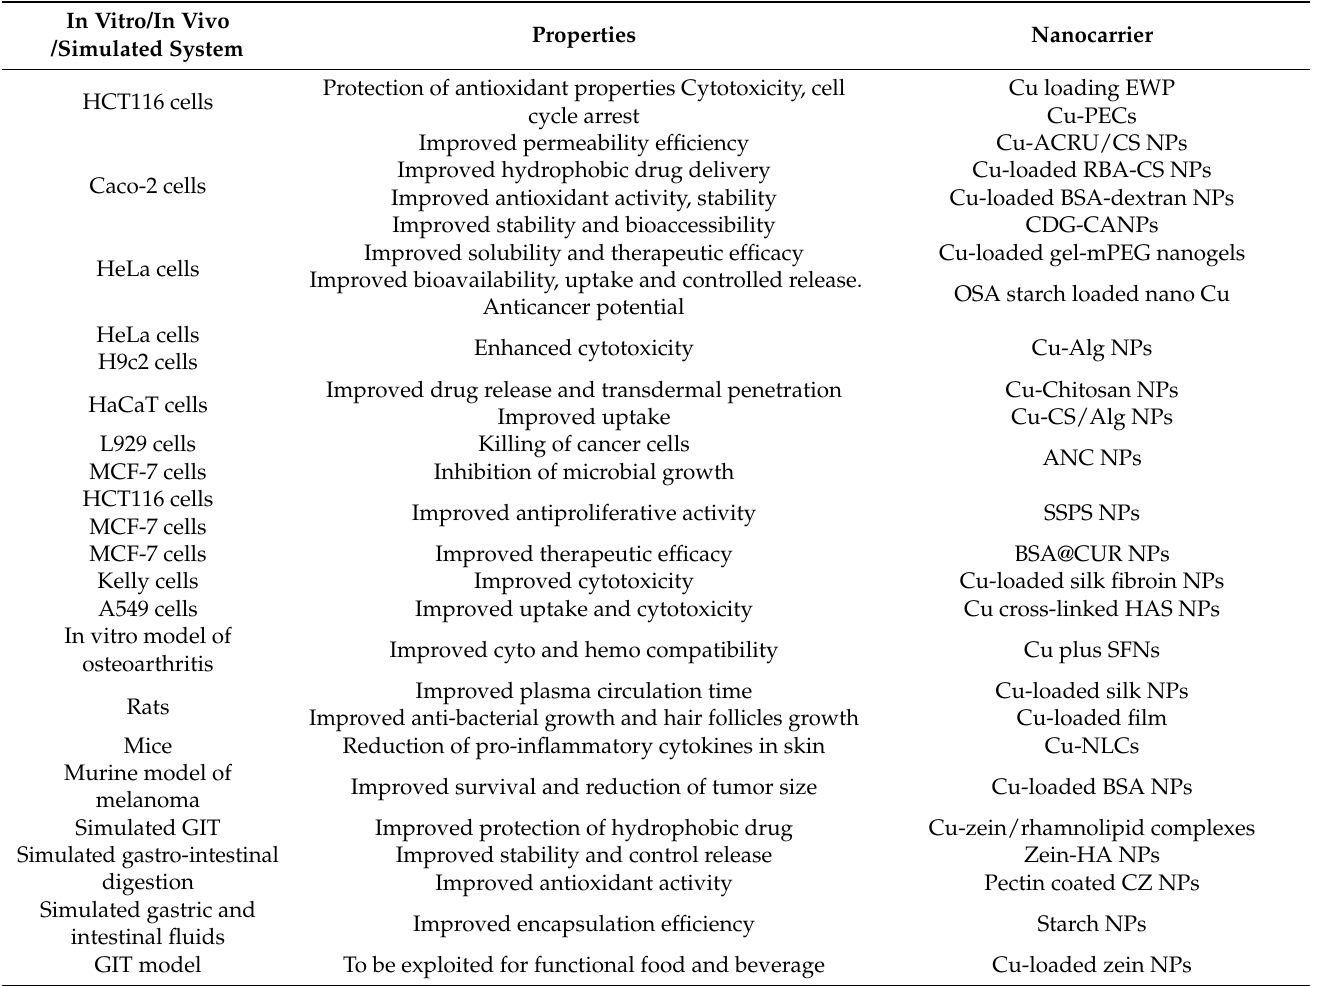
Table 7. In vivo and in vitro applications of bio-based curcumin nanocarriers. In Vitro/In